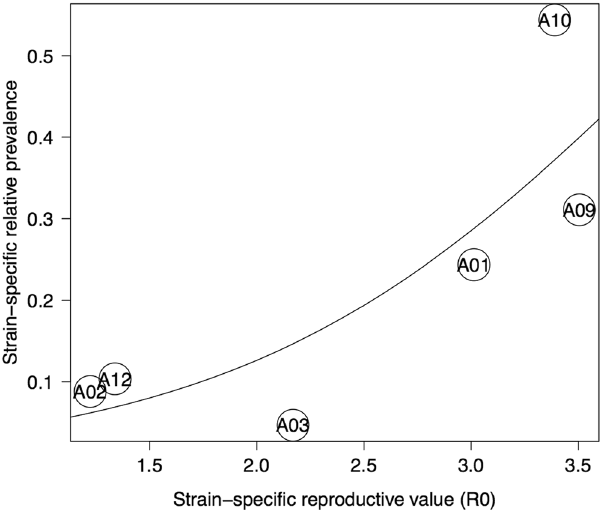
Figure 3. The reproductive numbers (R 0 ) of six B. afzelii oMG strains determine the strain-specific relative prevalences in a wild population of I. ricinus nymphs. Each data point is labeled with the name of the oMG of the B. afzelii strain. The strain-specific R 0 values were estimated from an experimental infection study using laboratory mice 43 . The strain-specific relative prevalences were estimated over the 11-year duration of the present study. The relative prevalence of an oMG strain is defined as the proportion of B. afzelii -infected nymphs that are infected with that particular oMG